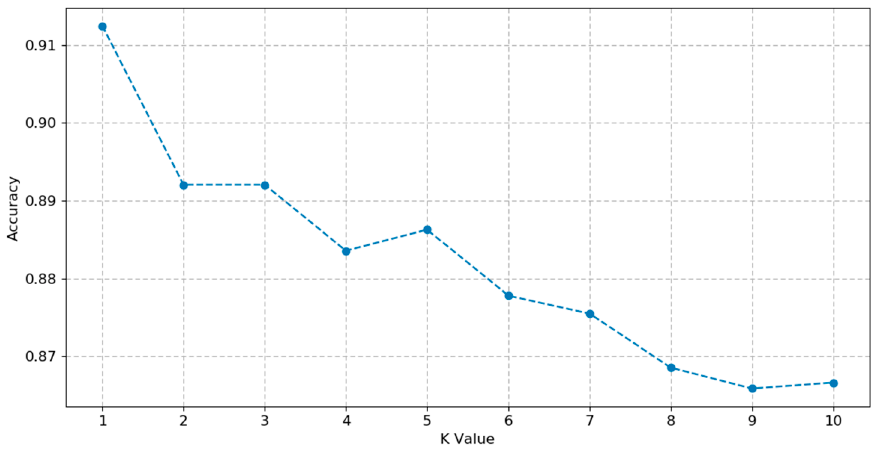
Figure 2. Mean accuracy as a function of K.